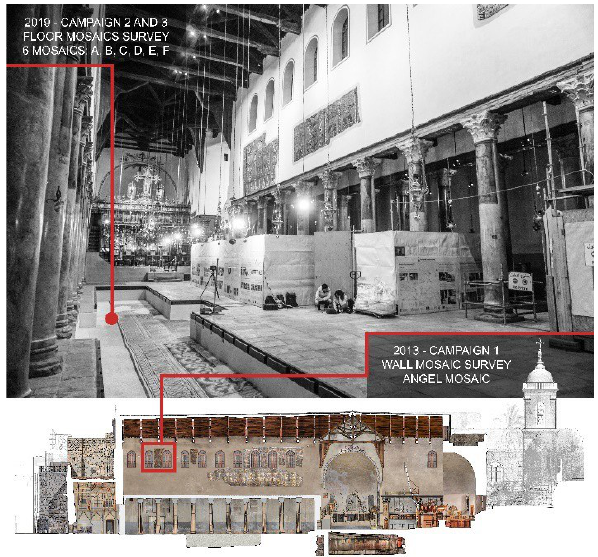
Figure 4. Position of the Angel wall mosaic and of carpet mosaics was carried out in several moments, depending on the restoration work in progress and the possibility of keeping the excavation